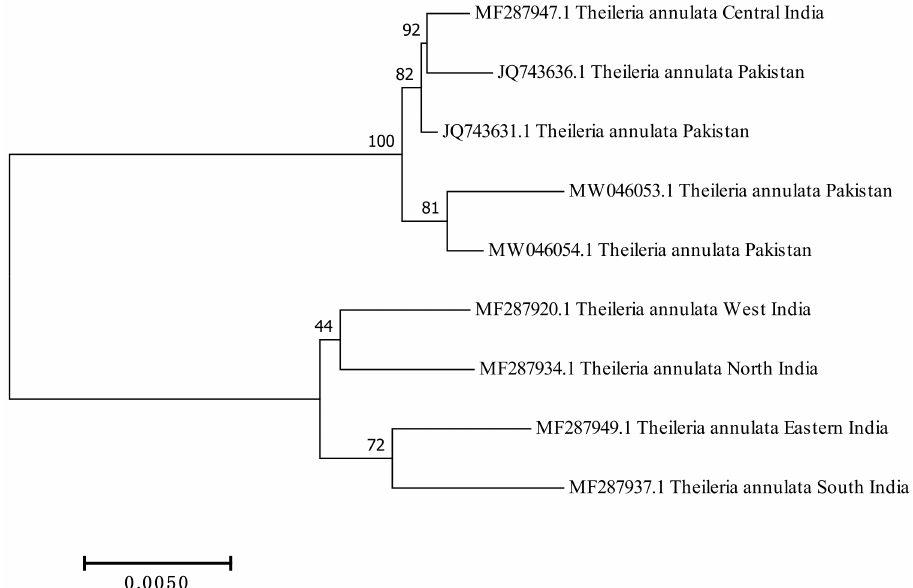
Figure 6. Phylogenetic analysis of selected T. annulata isolates ( 18 S rRNA